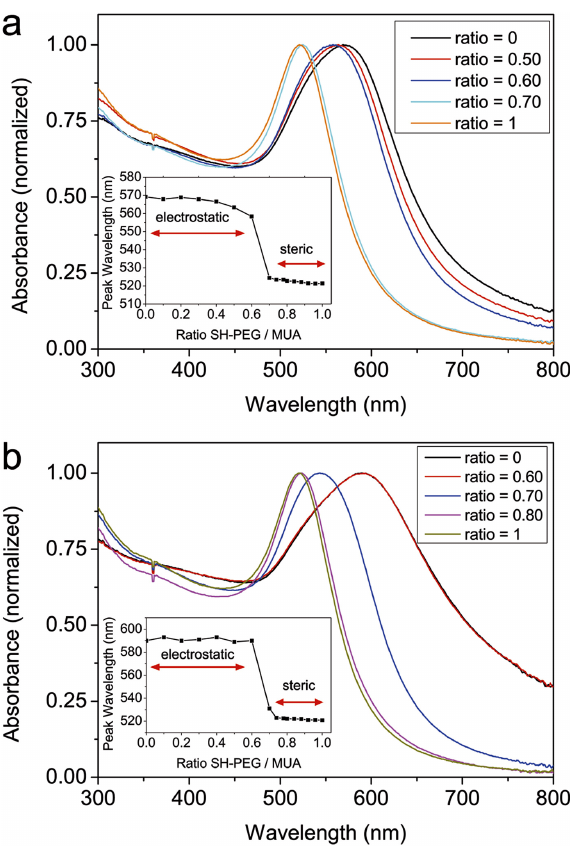
Figure 4 . Stability in physiologic and acidic media of concen- trated AuNPs. (a) The stability of AuNPs functionalized with different SH-PEG / MUA ratios was assayed by adding 10 % of 2.4 (cid:3) 10 14 NP/mL solution in DMEM supplemented with